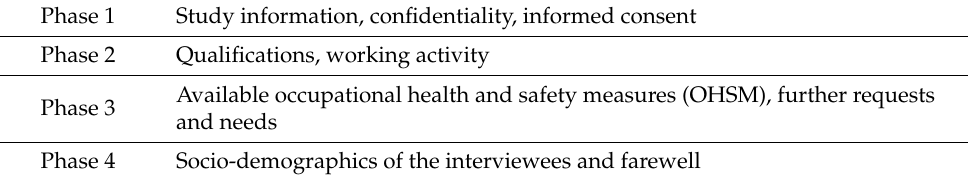
Table 1. Interview topic